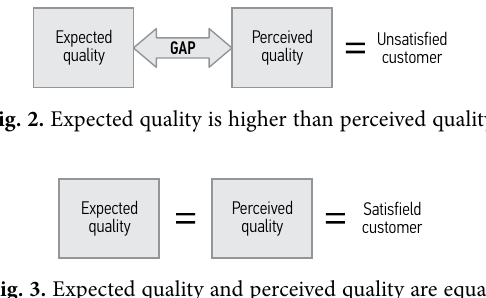
Fig. 3. Expected quality and perceived quality are equal